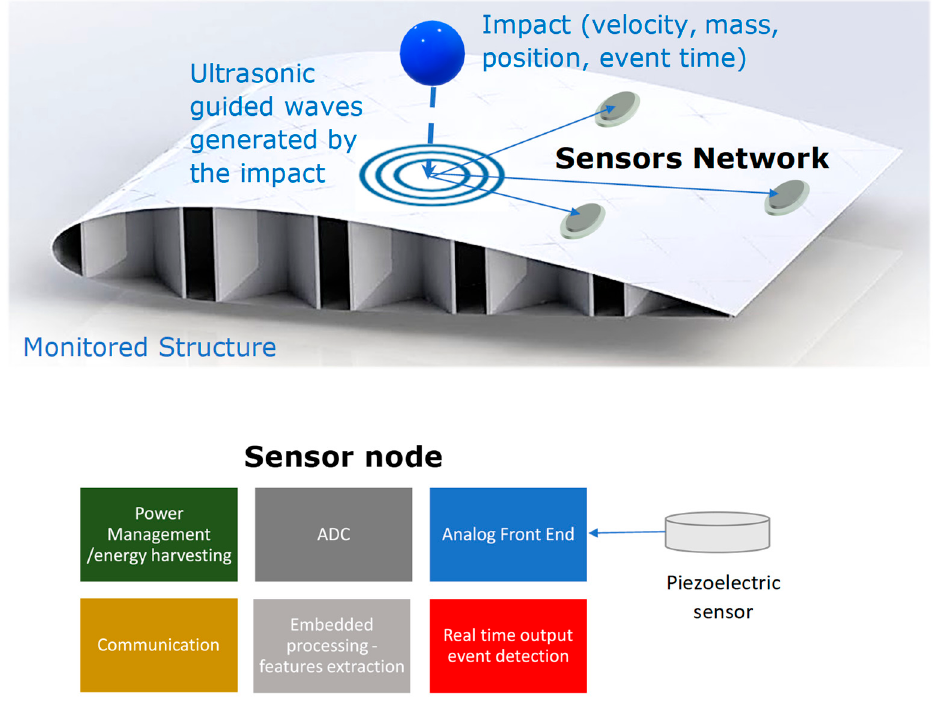
Figure 1. ( Top ) Graphical description of a continuous impact monitoring system based on a network of piezoelectric sensor nodes. ( Bottom ) Electronic blocks for a sensor node.